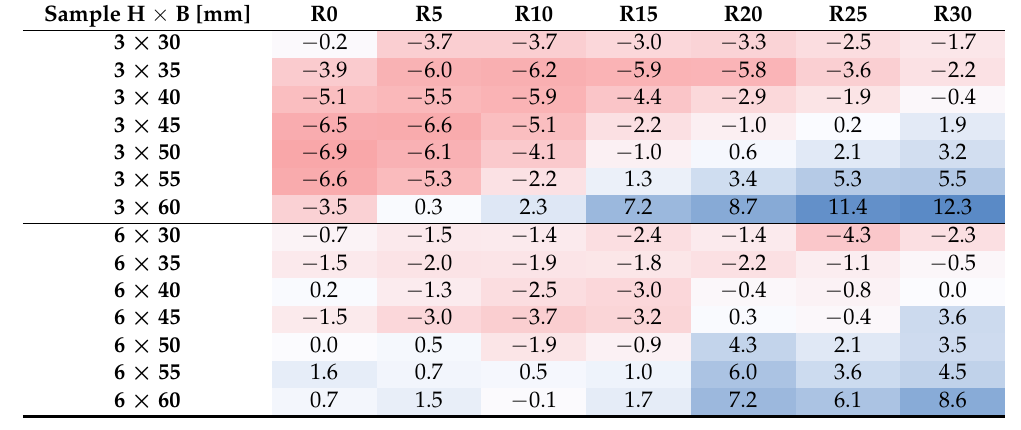
Table 6. Summary of the results of calculating the torsional moment [Nm] of unexpanded test sets using analytical, numerical and experimental